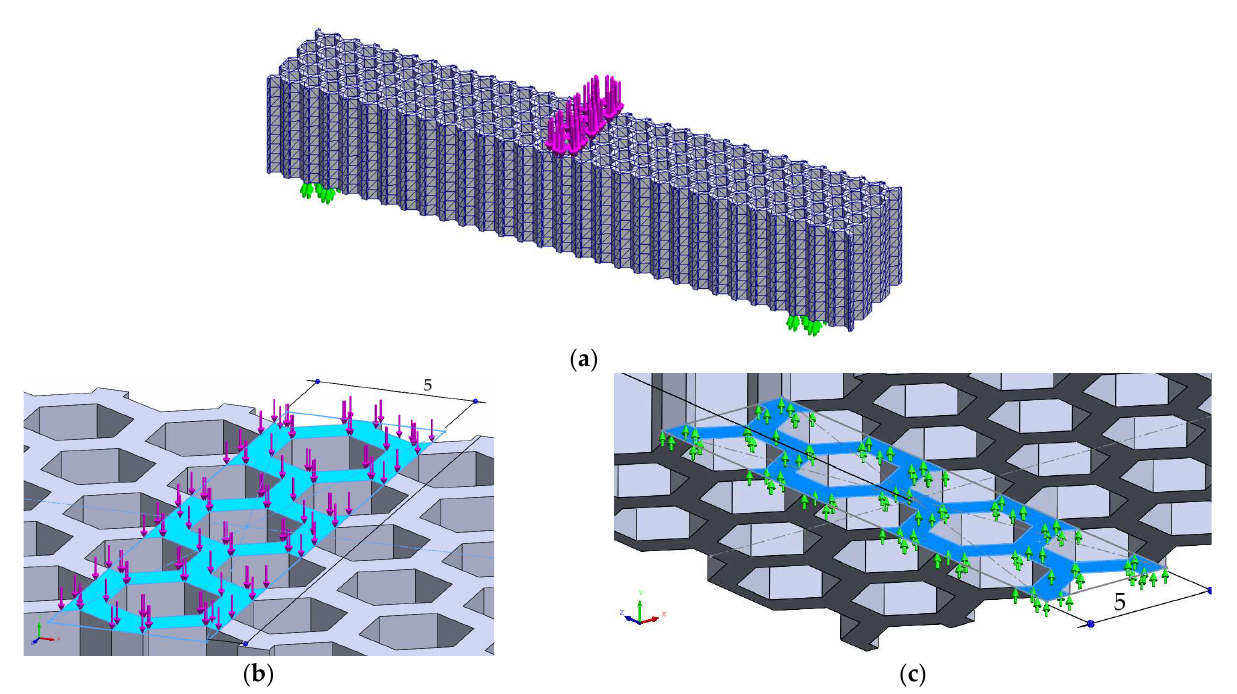
Figure 11. The FEM analysis setup for 3-point bending of the hexagonal structure—force applied along the Y -axis of the specimen: ( a ) general view, ( b ) detailed view of the loading force, ( c ) detailed view on fixing conditions (identically for both fixing areas).